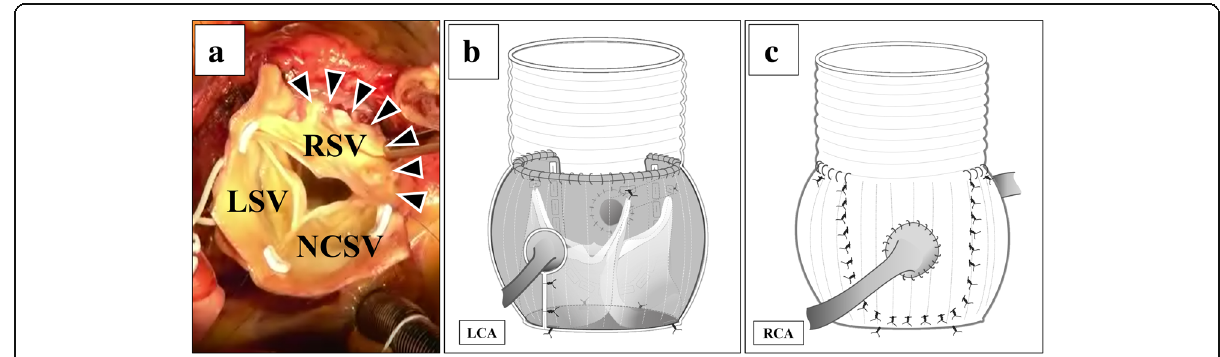
pledged with Teflon felt to reinforce the fragile aortic wall. SVA: sinus of Valsalva aneurysm; RSV: right sinus of Valsalva; LSV: left sinus of Valsalva; NCSV: non-coronary sinus of Valsalva; RCA: right coronary artery; LCA: left coronary